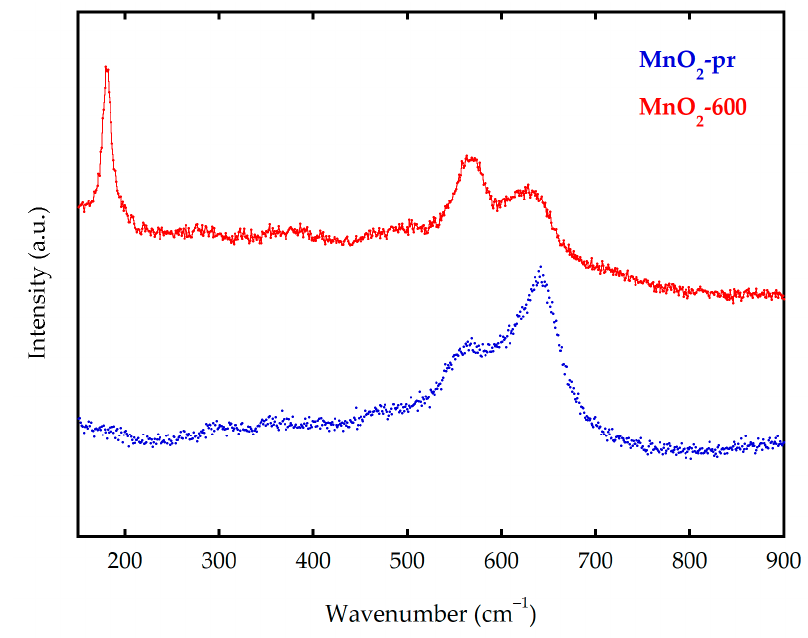
Figure 2. Raman spectra of both manganese dioxide samples obtained by the synthesis and further heat treatment.